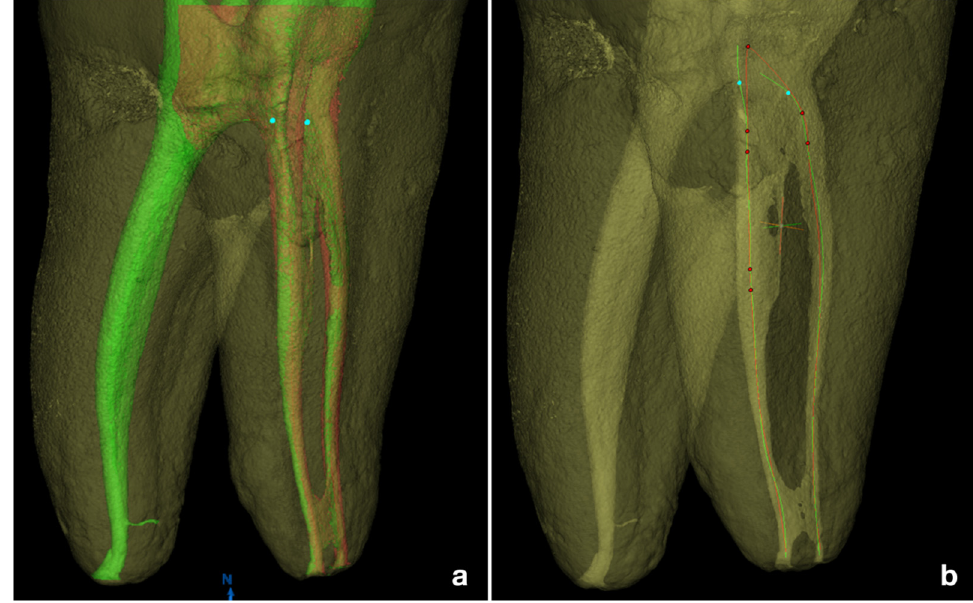
Figure 2. ( a ). 3D matching of pre-operative (green) and post-shaping (red) canal volumes, and ( b ). the pre-operative (green) and post-shaping (red) root canal centroids in the mesial canals.